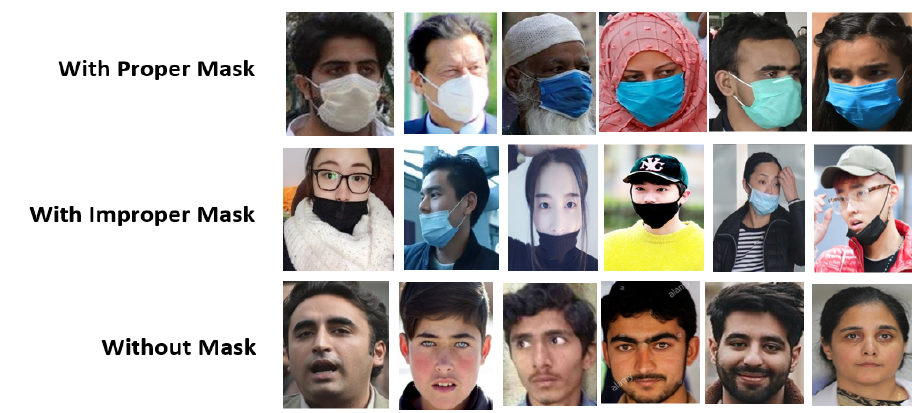
Figure 10. Sample of dataset